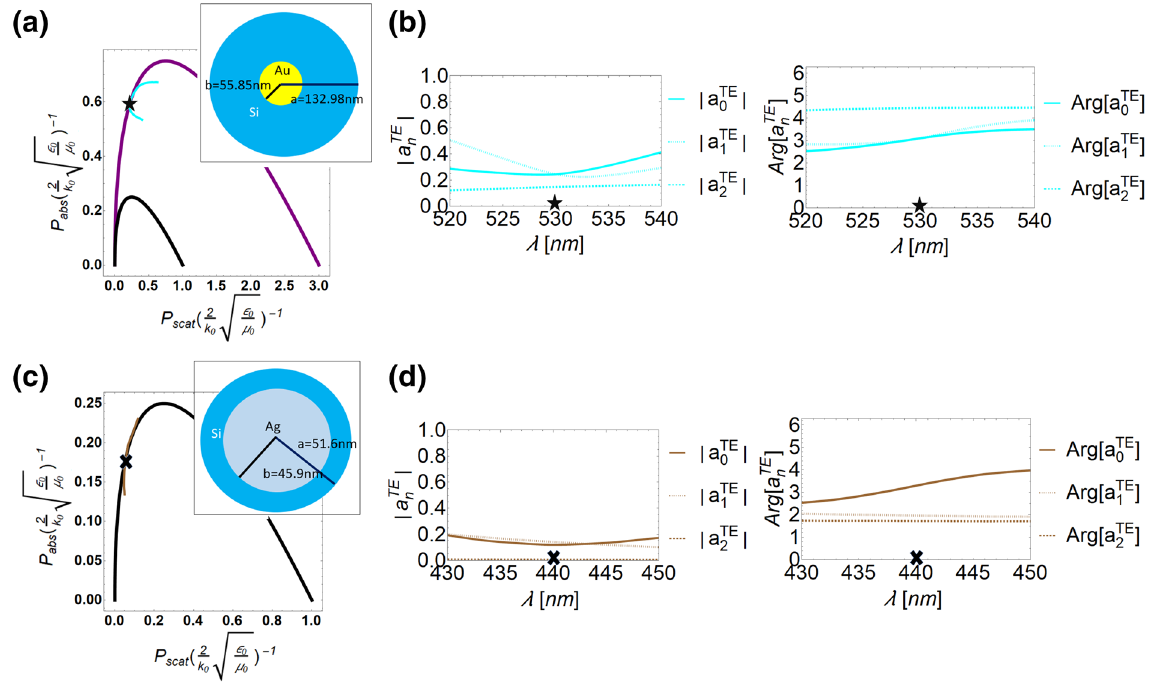
Figure 3. Power distributions of two different systems by tuning operating wavelength in ( a ) and ( c ), respectively. In ( a ), the cyan line represents the gold-silicon core-shell system with an outer radius of 132.98 nm and a ratio of the inner to outer radius of 0.42. The corresponding magnitudes and phases of the scattering coefficients in this gold-silicon system are shown in ( b ). The operation wavelength in this system is from 520 to 540 nm. An intersection of the N = 1 boundary is occurred at operating wavelength 530 nm, marked by a black star. In ( c ), this system is made of silver-silicon core-shell with outer radius of 51.6 nm and ratio of outer-inner radius of 0.89. The operating wavelength for this system is from 430 to 450 nm. An intersection of the N = 0 boundary is at 440 nm, marked by a black cross. The magnitudes and phases of dominant scattering coefficients in this operating wavelength window are shown in ( d